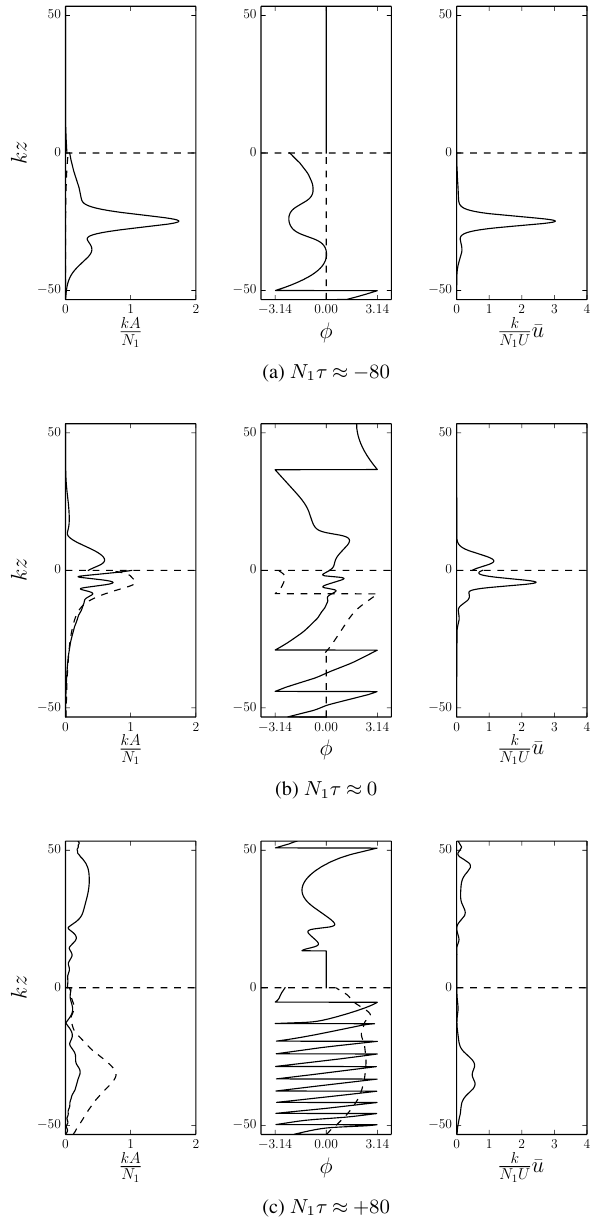
Figure 6. Vertical profiles of the wave magnitudes A (left panel), phases φ (center panel), and mean flow (right panel) at three times in two layers. The parameter values are n 1 /k = 0.4, N 2 /N 1 = 2, (cid:15) = 0.025, and α = 0.1. The line conventions are the same as Fig. 3.